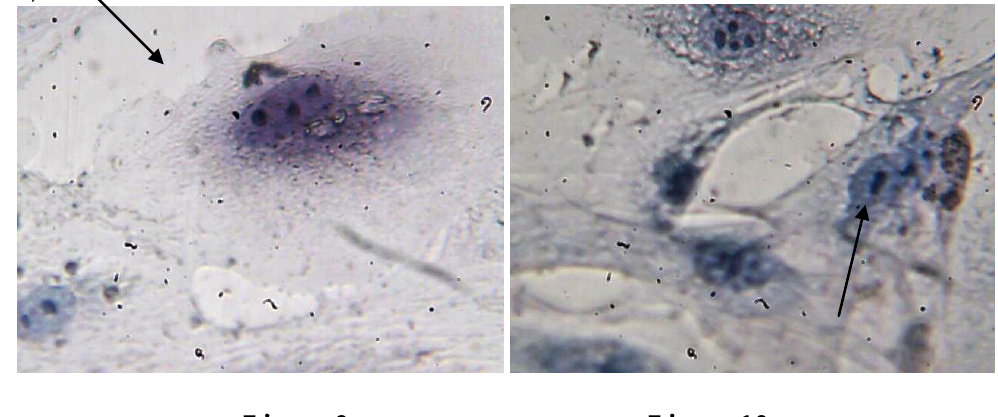
Figure (9, 10): Intracytoplasmic inclusion bodies ( ) after 72 hours post infection 400X.